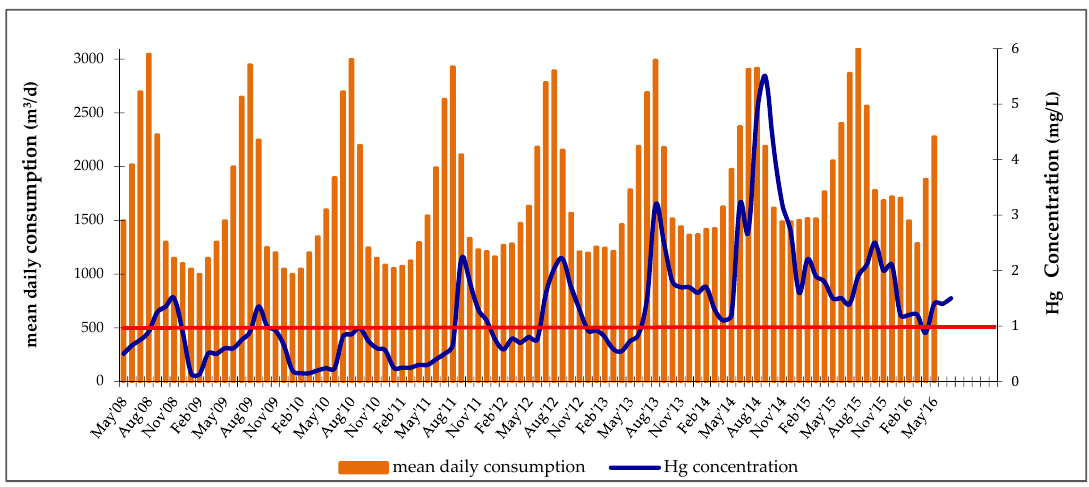
Figure 1. Mean daily water consumption (green bars) and Hg concentration (blue line) from 2008 to 2016 for the island of Skiathos. The red line is the Maximum Concentration Limit of Hg for drinking